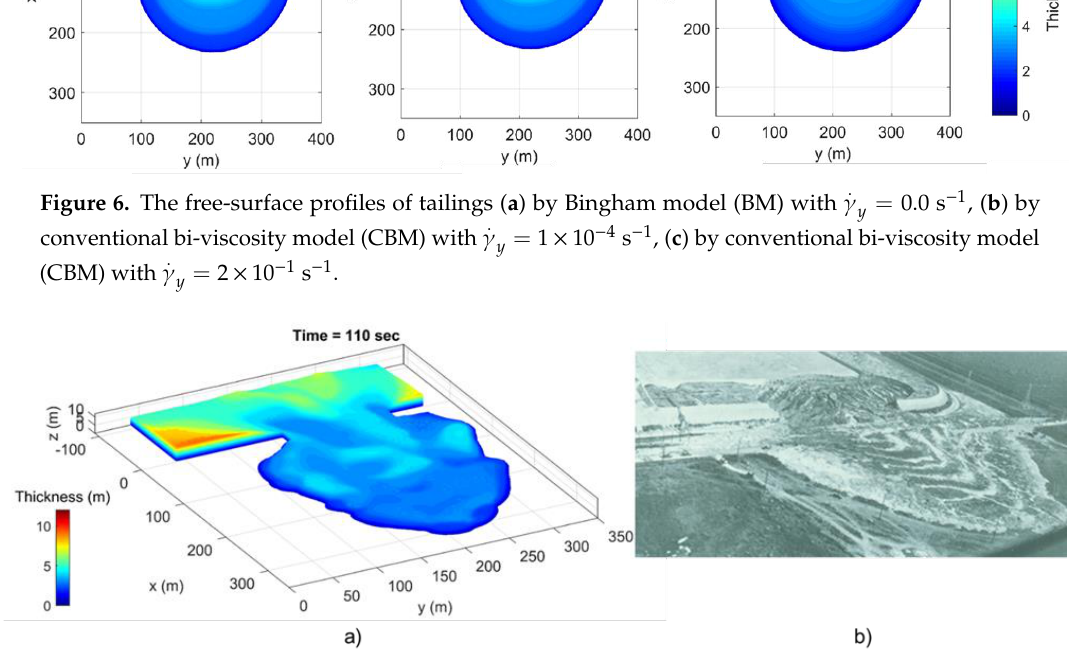
Figure 7. The free-surface profile of tailings. ( a ) The simulated modified bi-viscous model (MBM) at the stoppage t = 110 s; ( b ) the aerial photo of the FGT66 [60].